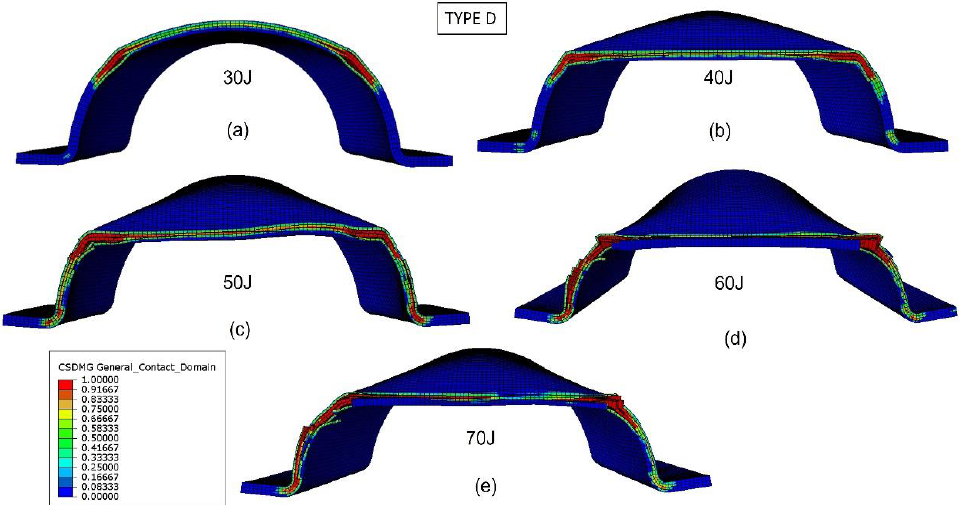
Figure 16. Delamination initiation criterion at the middle cross section of bumper beam Type D. Impact energy: 30 J ( a ), 40 J ( b ), 50 J ( c ), 60 J ( d ), and 70 J ( e ).